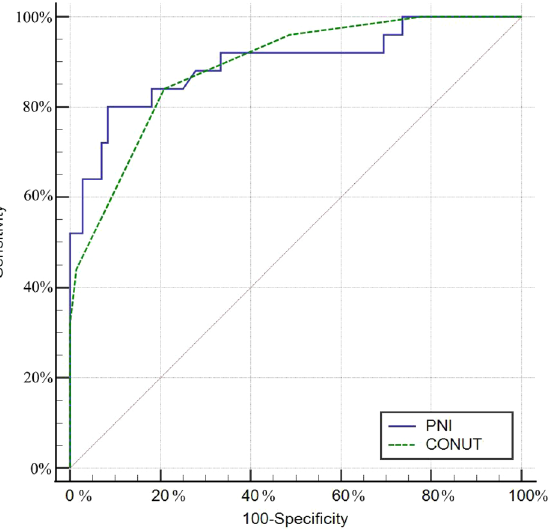
Figure 1. Receiver operating characteristic analysis of PNI and CONUT score in predicting prognosis of STB postoperatively. CONUT controlling nutritional status, PNI prognostic nutrition index, STB spinal